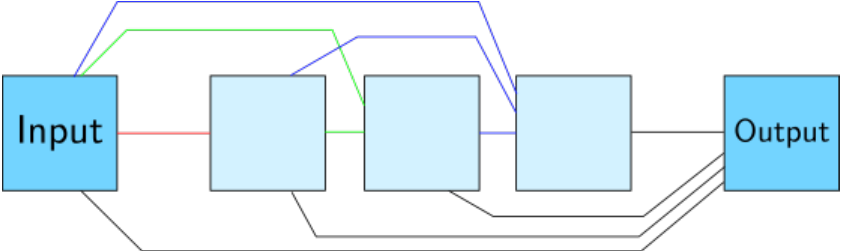
Figure A3. Architecture of the MS-D neural network for width of 1 and depth of 3, feature maps are drawn as light blue squares. Colored lines represent dilated convolutions, different colors correspond to different dilation values. Black lines represent 1 × 1 convolutions that connect the input and all feature maps to the output image. Adapted from